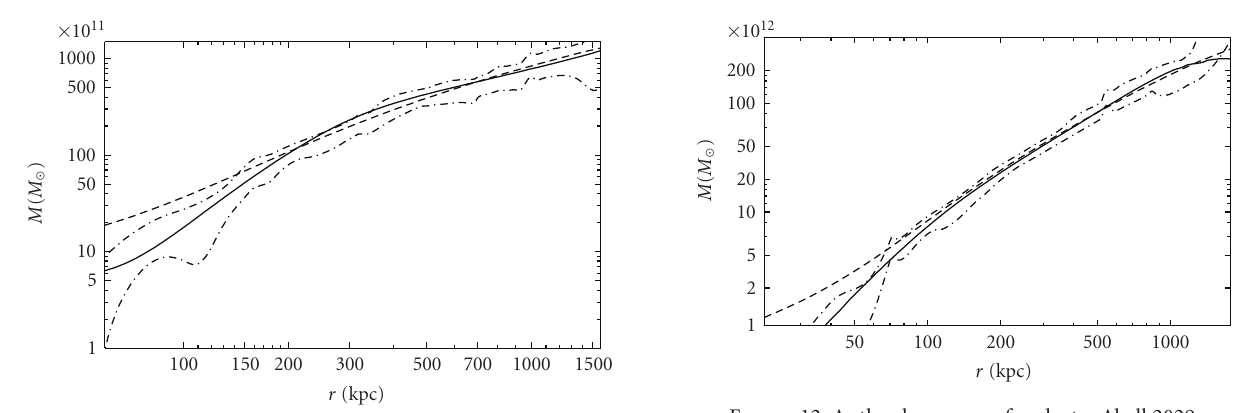
Figure 10: As the above cases, for cluster Abell 478.